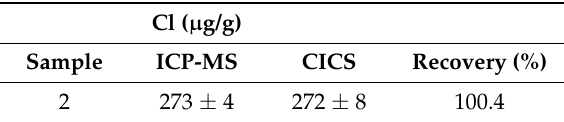
Table 5. The results of determination of chlorine in sample 2 by elaborated (ICP-MS) and reference (CICS) methods. Recovery concerns ICP-MS method relative to the reference one